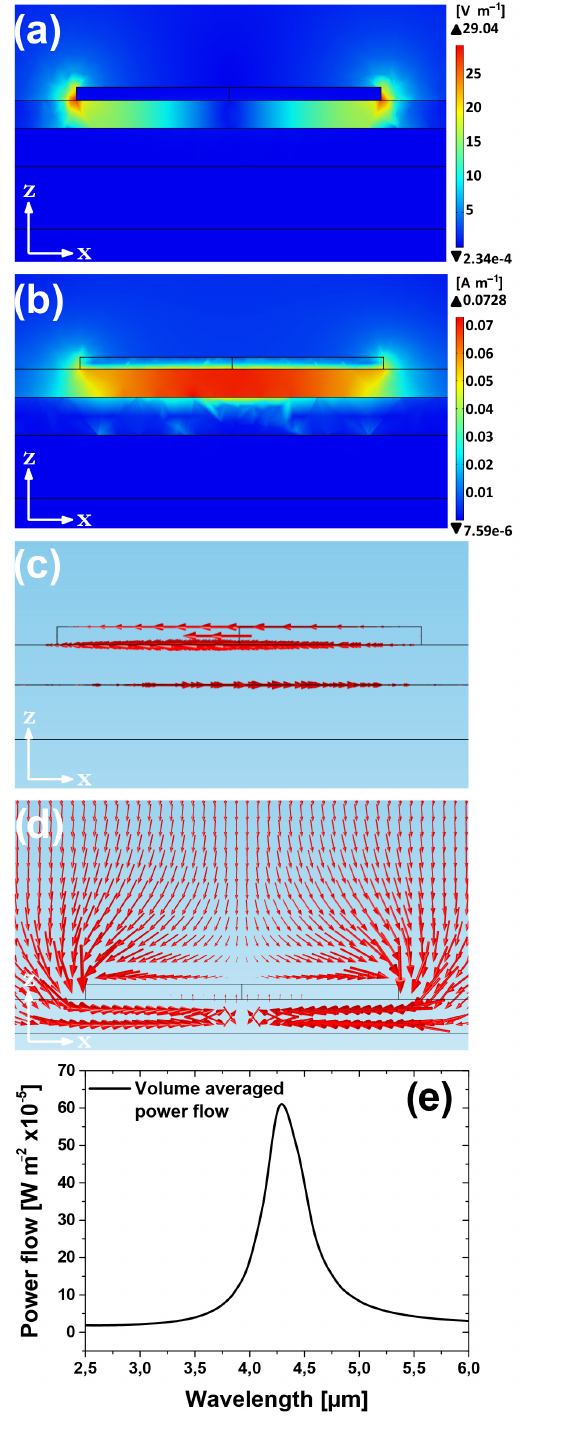
Figure 2. Optical properties of metamaterials for simultaneous electric and magnetic resonances. (a) Normalized electric field and (b) magnetic field. (c) Surface current density. (d) Time-averaged energy flow defined by the Poynting vector. (e) Volume-averaged energy flow ( z component) over the spectral range of